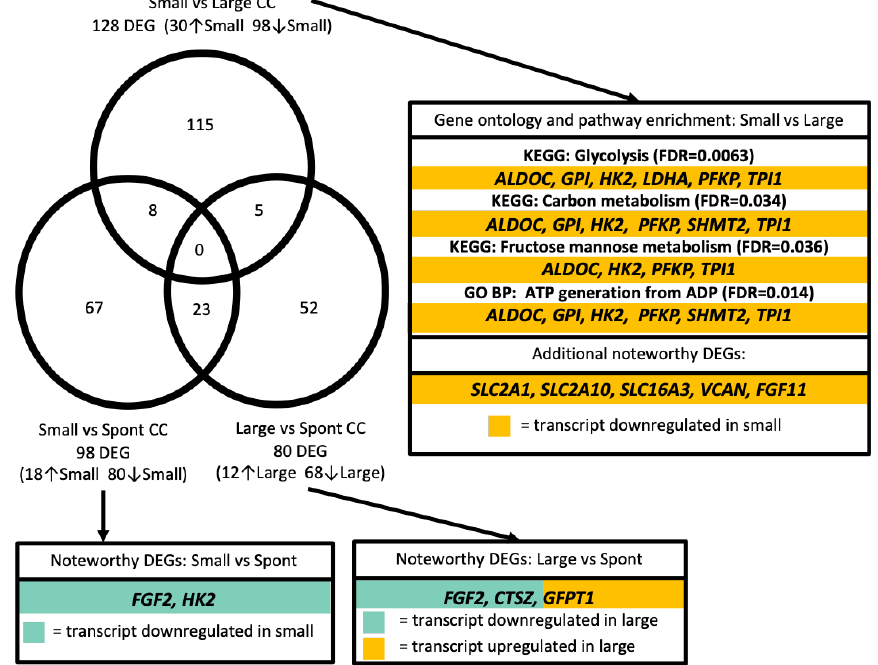
Figure 3. Differential gene transcript abundance among cumulus cell (CC) pools. Venn diagram displaying 128, 98, and 80 differentially abundant gene transcripts (DEGs) in comparisons of Small vs. Large, Small vs. Spontaneous (Spont), and Large vs. Spont CC pools, respectively. A total of 115, 67, and 52 DEGs were identified in only Small vs. Large, Small vs. Spont, or Large vs. Spont CC comparisons, respectively. A total of 8 transcripts were identified as DEGs in both Small vs. Large and Small vs. Spont comparisons; 5 transcripts were identified as DEGs in both Small vs. Large and Large vs. Spont comparisons; and 23 transcripts were identified in both Small vs. Spont and Large vs. Spont comparisons. No transcripts appeared as DEGs in all three comparisons of follicle classifications. Example gene ontology (GO) and KEGG pathways significantly enriched with DEGs, alongside additional noteworthy DEGs, are indicated for each comparison.